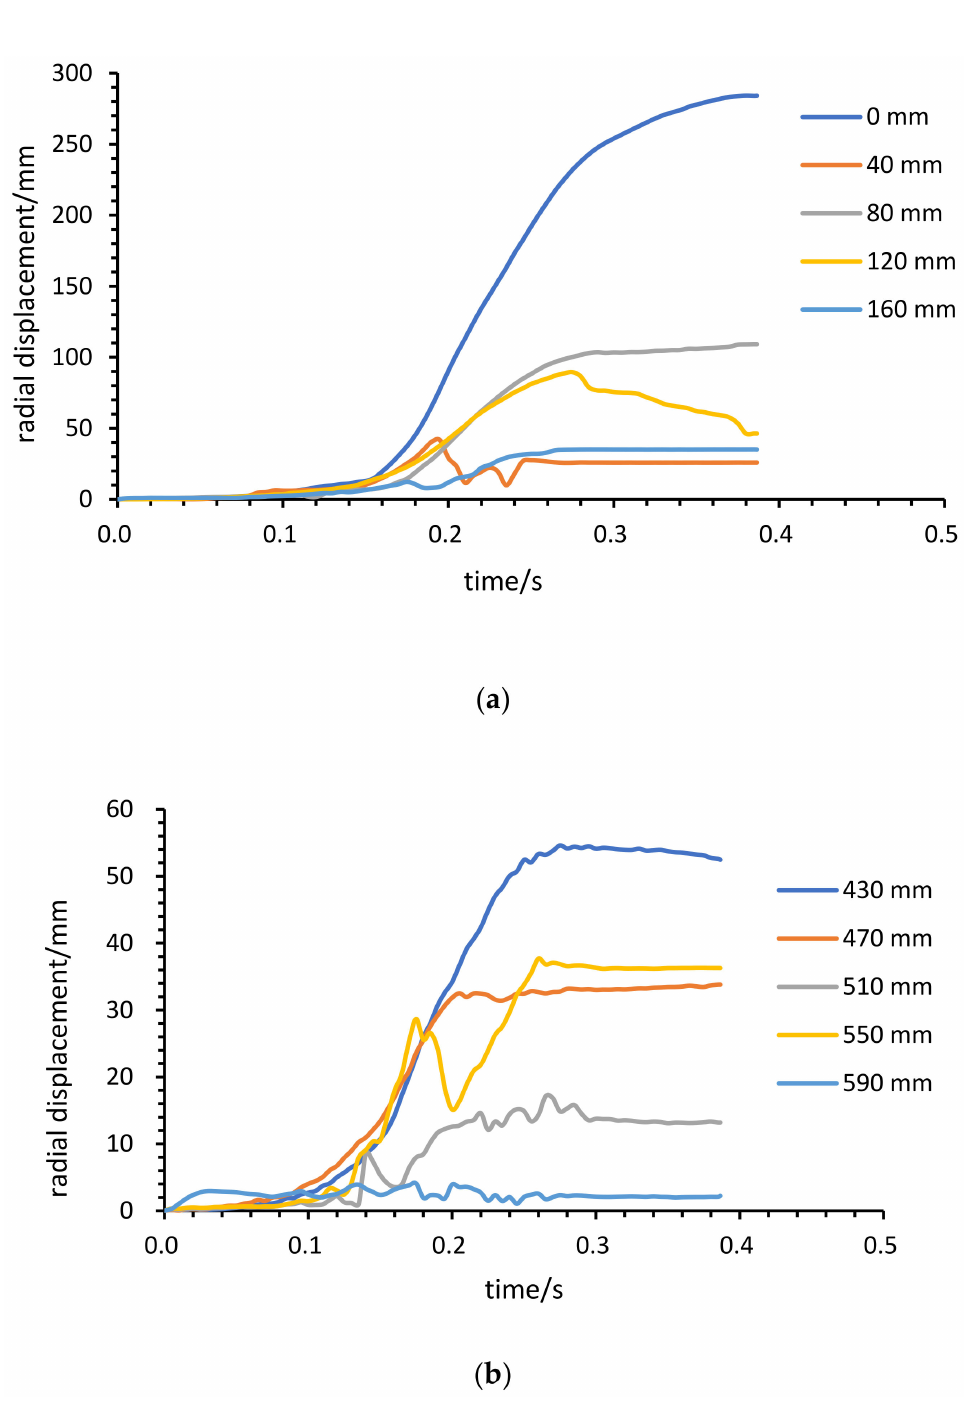
Figure 8. Spliced pile ( a ) Pile side; ( b ) Soil particle displacement at pile